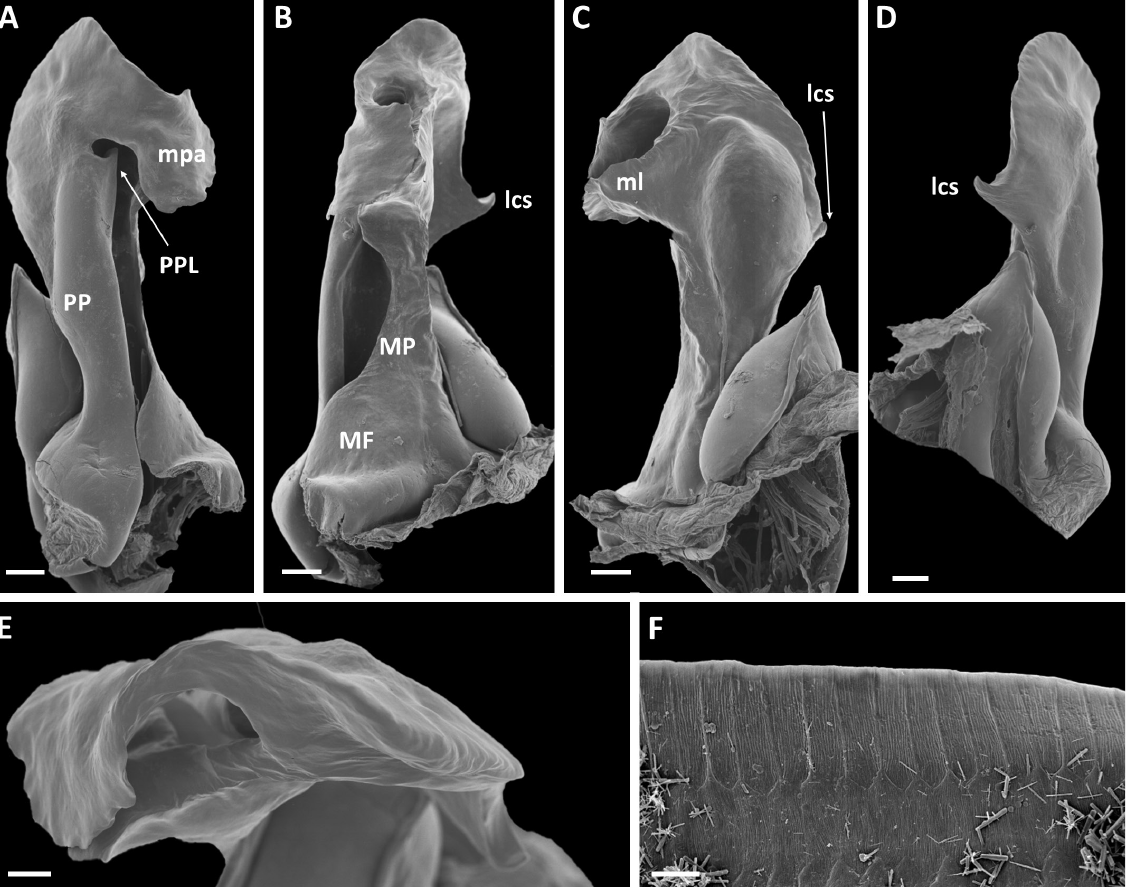
Fig. 35. Chaleponcus soerensenae sp. nov., holotype, ♂ (NHMD 621735). A–E . Left gonopod coxa. A. Anterior view. B. Mesal view. C. Lateral view. D. Lateral view. E. Distal view. F . Midbody dorsal limbus. Abbreviations: lcs = latero-posterior coxal spine; MF = metaplical flange; ml = metaplical lobe; MP = metaplica; mpa = metaplical palette; PP = proplica; PPL = proplical lobe. Scale bars: A–D = 0.1 mm; E = 0.05 mm; F = 0.01